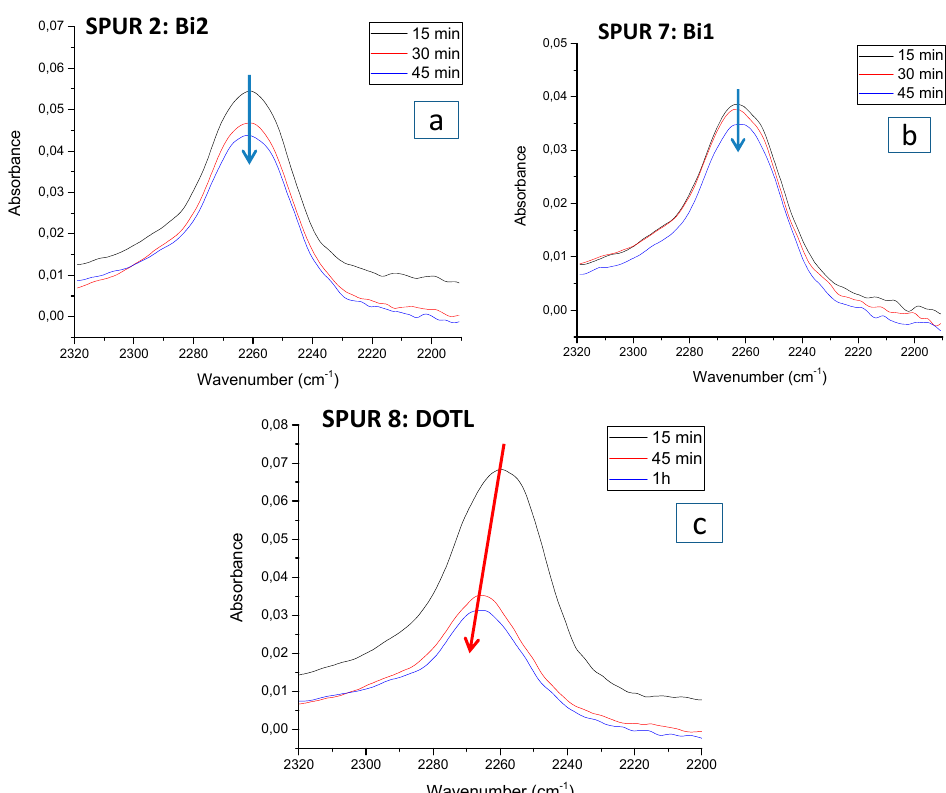
Figure 7. ATR-FTIR spectra in the isocyanate stretching region of samples taken at different reaction times during 1st stage reaction for different catalyst systems: ( a ) SPUR 2 (Bi2); ( b) SPUR 7 (Bi1); ( c ) SPUR 8 (DOTL).